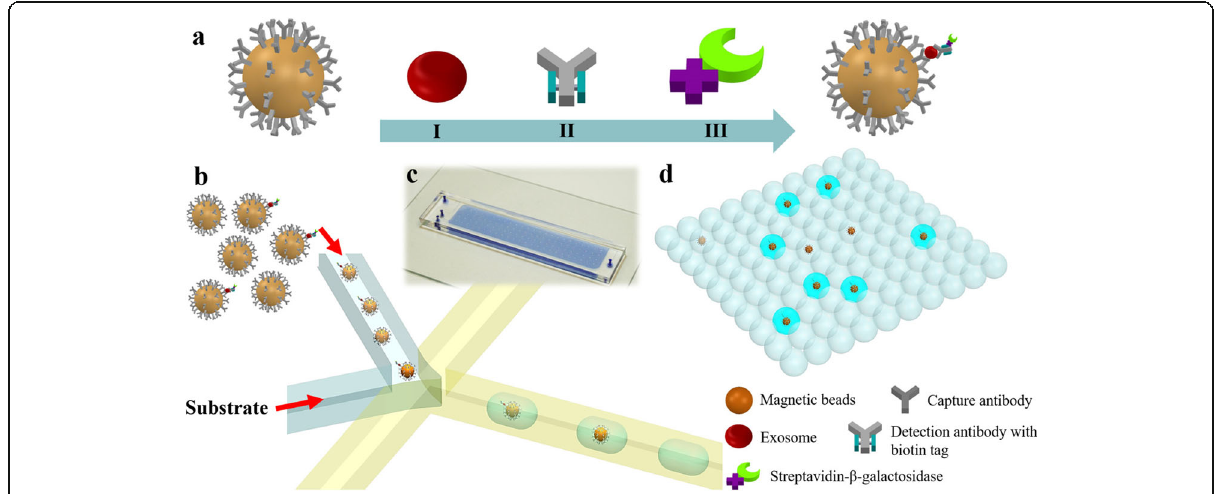
Fig. 7 The droplet digital ExoELISA for exosome quantification [138]. Copyright© 2018 American Chemical